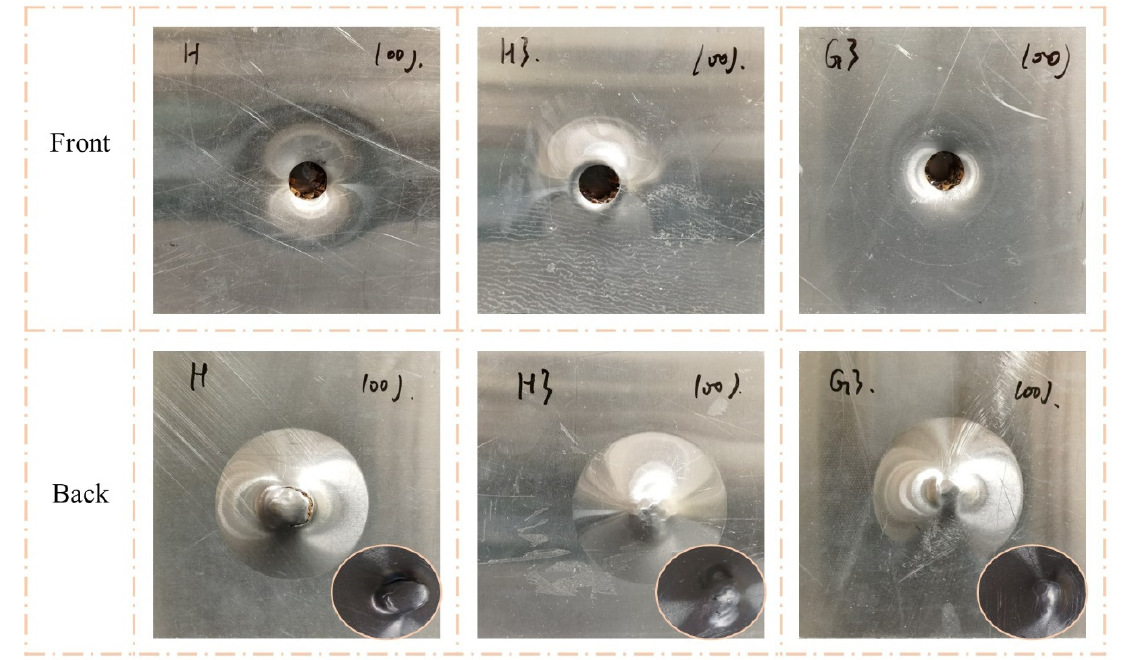
Figure 14. Damage modes of H, H3, and G3 under 100 J impact energy with flat impactor.